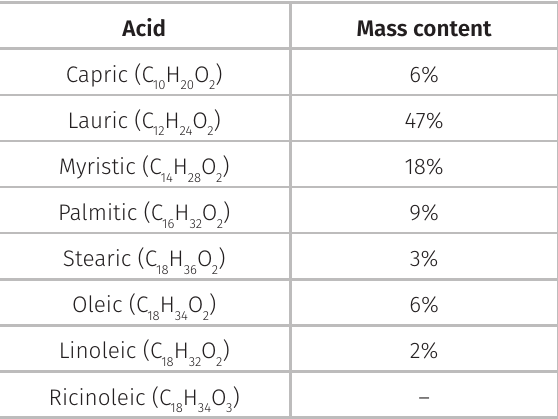
Table I. Mean composition in fatty acids present in the coconut oil